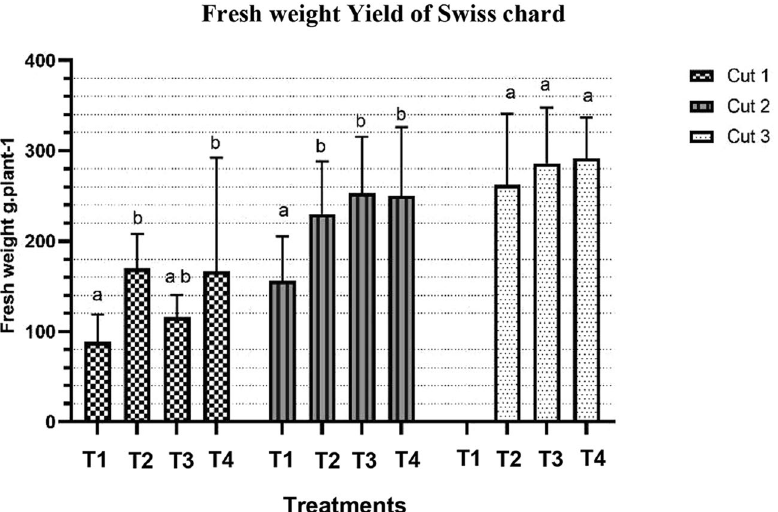
Figure 3. Effect of different treatments on fresh weight of Swiss chard at different cut numbers. Data are expressed as mean ± SD (n = 24). Error bars represent the standard deviation. Bar columns within the same cut number having the same letter at the top are not significantly different ( P > 0.05). T1 Deep water culture, T2 October, T3 Beni suef, T4 Fayoum.